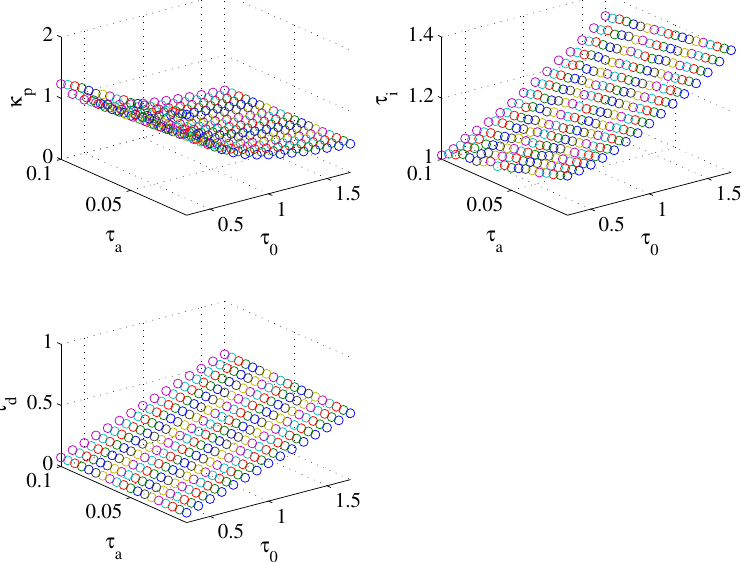
Figure 2. Relationships among optimized controller parameters and the normalized parameters τ 0 and τ a in servo